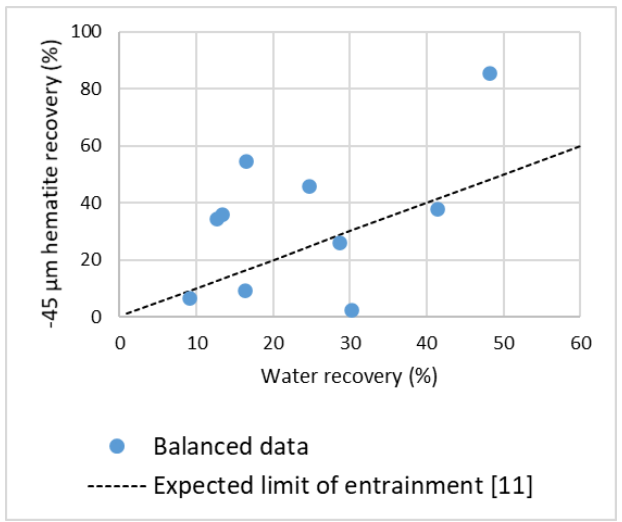
Figure 4. −45 µm hematite recovery as a function of measured water recovery. Figure 4. − 45 µ m hematite recovery as a function of measured water